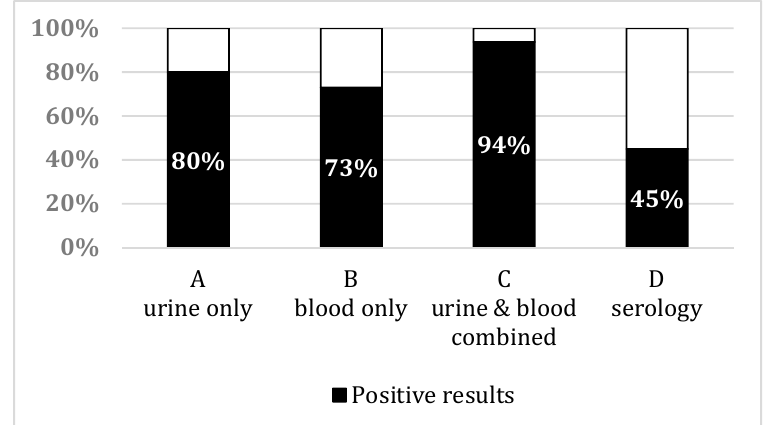
Figure 1. Percentage of leptospirosis diagnosis confirmed in our patients based on positive PCR results among: ( A ) Urine samples only, ( B ) blood samples only, ( C ) when combining urine and/or blood for each patient. The percentage of positive serology results among all serological samples is given in ( D ) as a comparison.